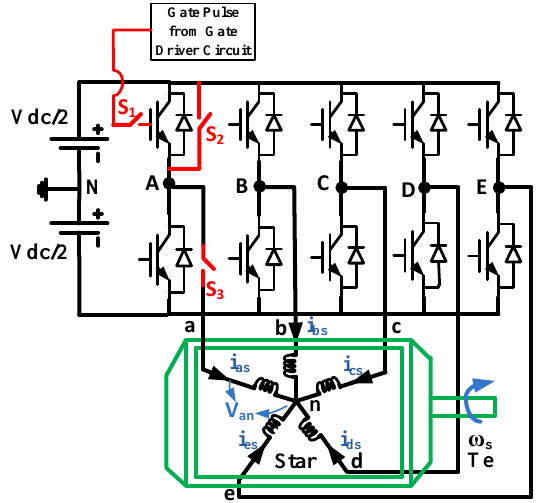
Figure1. Five-phase system with 1-Ph fault. Figure 1. Five-phase system with 1-Ph